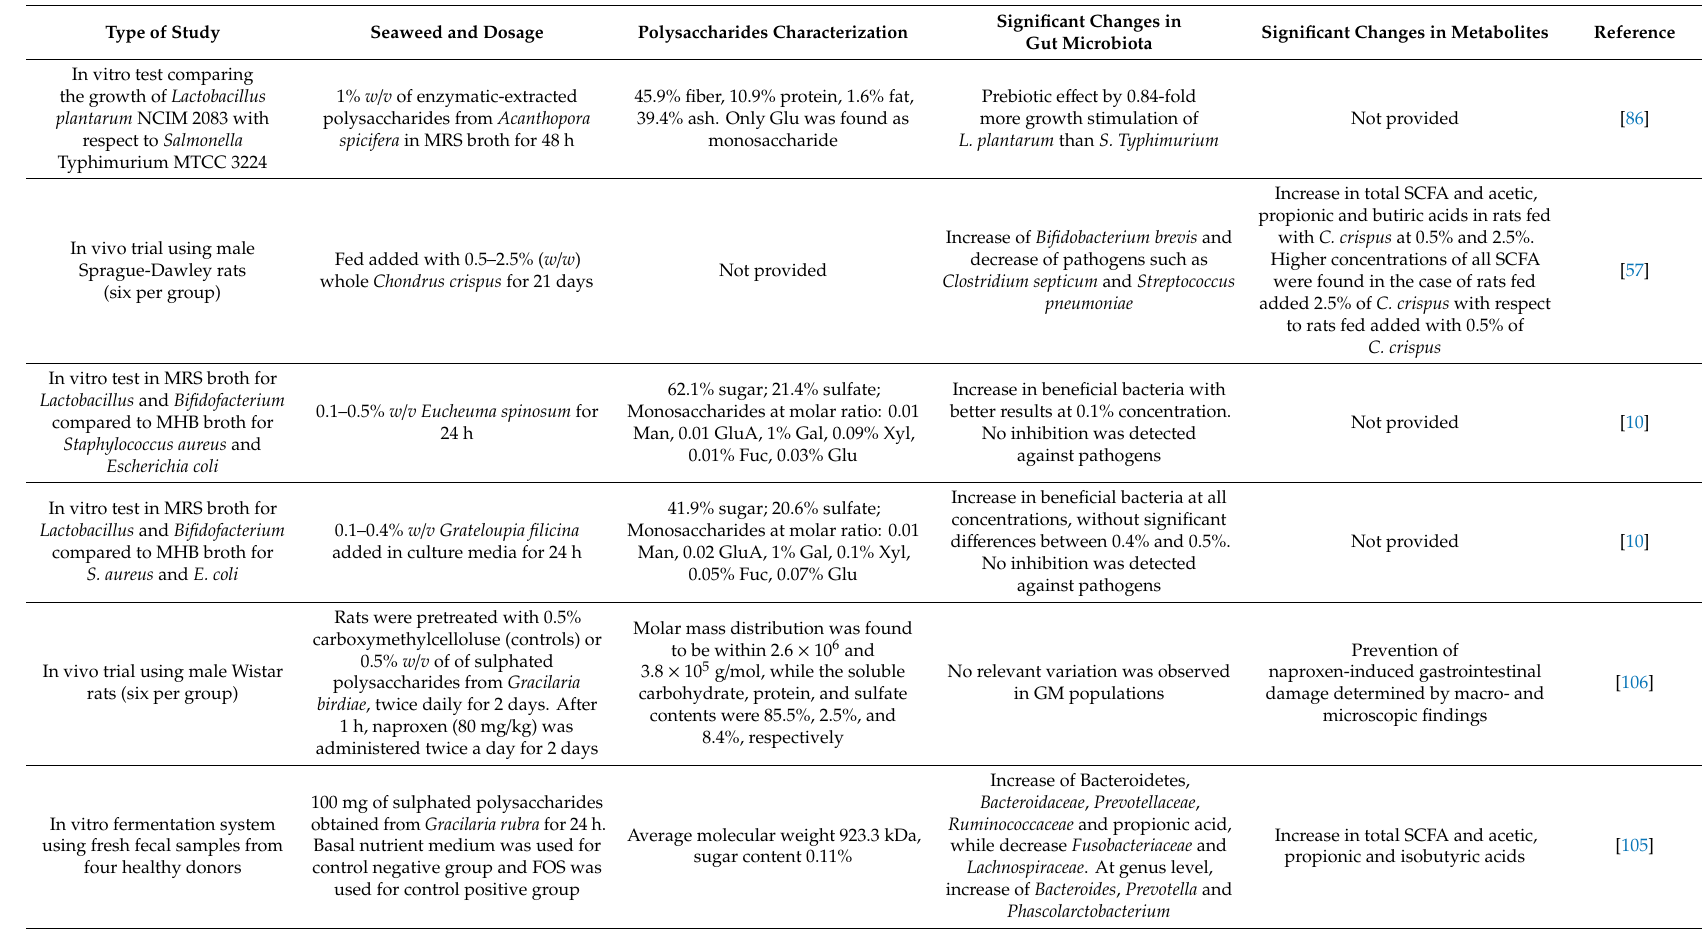
Table 2. Prebiotic e ff ect of di ff erent species of red